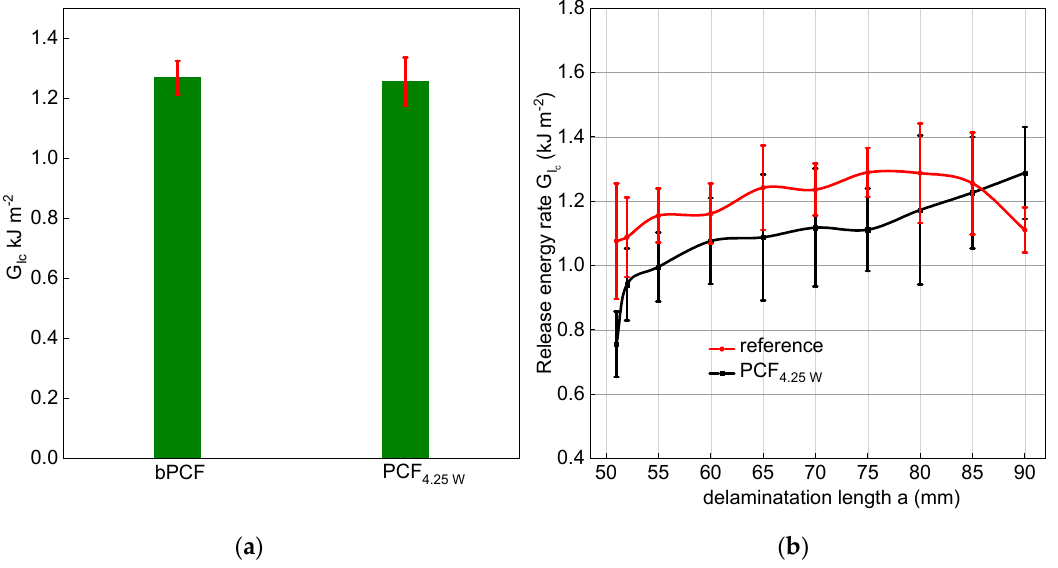
Figure 12. ( a ) Average G Ic mode-I interlaminar fracture toughness. ( b ) Propagation R-curves for both reference and PCF 4.25 W